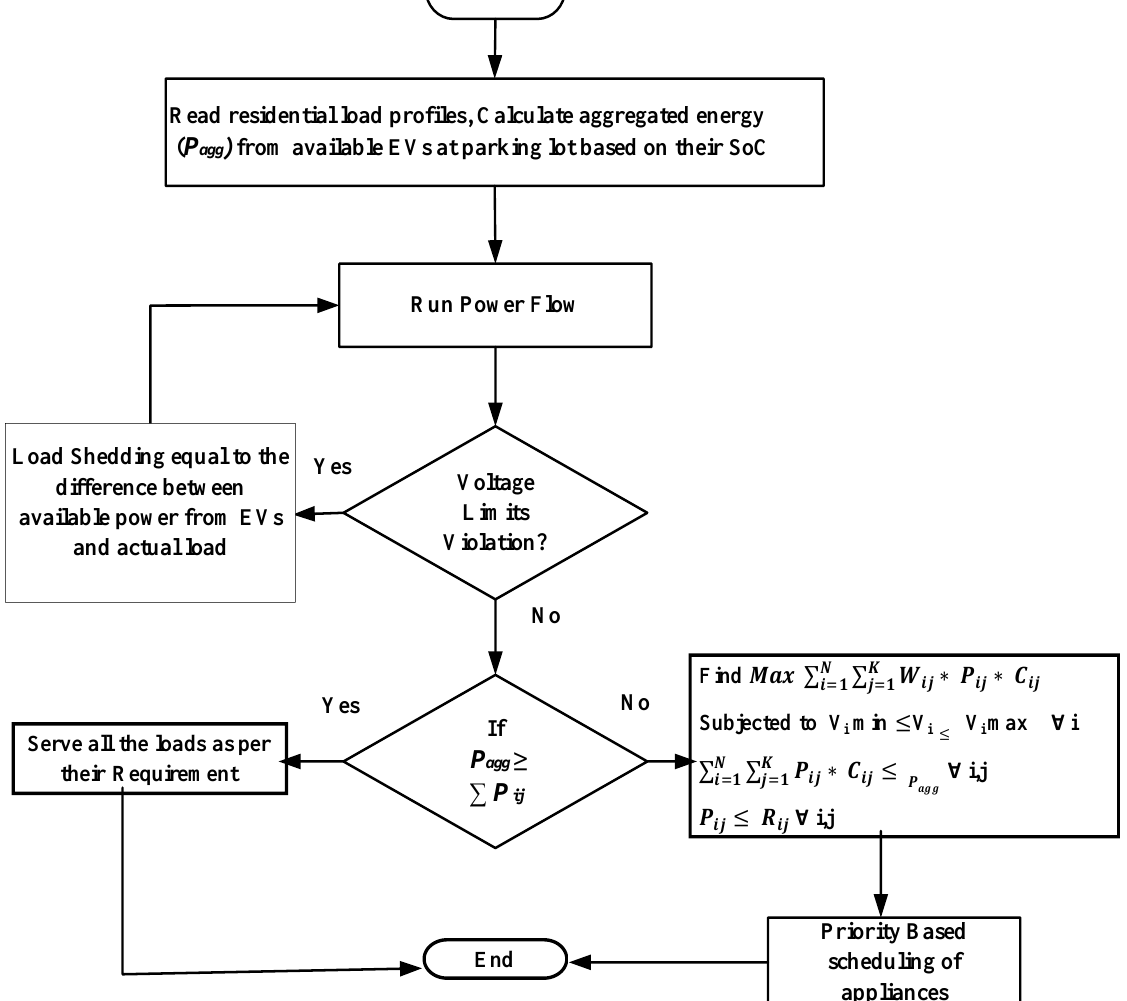
Figure 5. The flowchart of the priority-based scheduling of the appliances